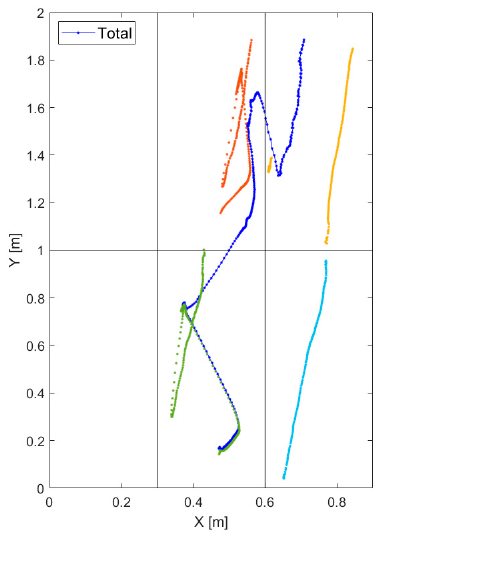
Figure 6. Trajectory extrapolation: case of a person pulling a luggage on wheels ( a ) 2D, ( b ) 3D. The accuracy performances of the described gravimetric system were evaluated using the method introduced in Section 2.2, applying Equations (6)–(11). The obtained trajectories and related error envelopes were similar to the results shown in Figure 3, with a maximum error on the assessment of the net force application point location of 10 cm (uncertainty 3 cm).